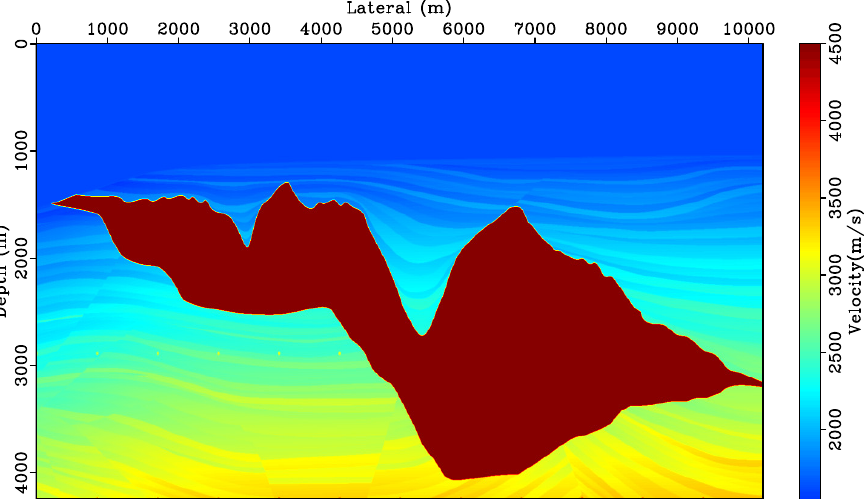
Figure 6. The 2D Sigsbee model had 500 × 1200 grid nodes with a grid spacing h = 8.5 (m) and variation in the velocities from 1550 to 4500